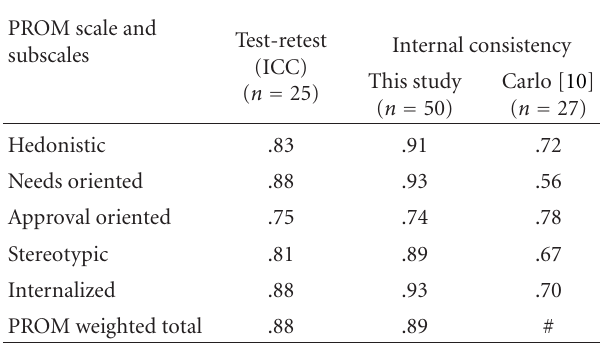
Table 1: Reliability study of the Chinese